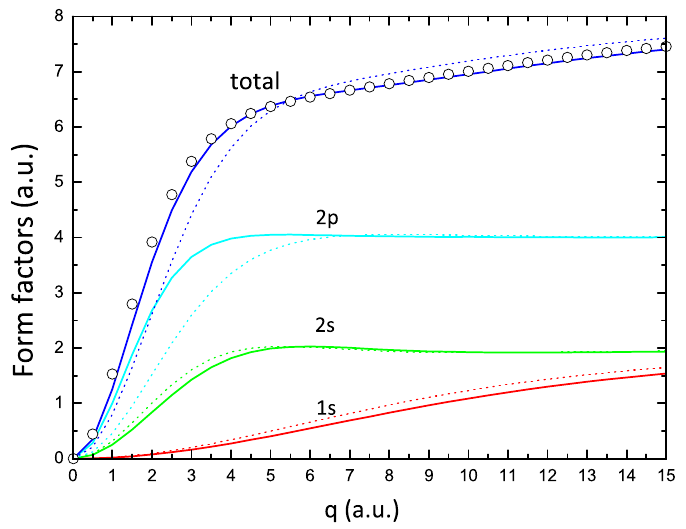
Figure 4. Form factors corresponding to 1 s , 2 s , and 2 p electrons obtained from the one-parameter (dotted lines) and two-parameter (solid lines) formulations, and the corresponding total form factors for Oxygen; the circles are the values of the form factor obtained from the HF calculations of Ref.